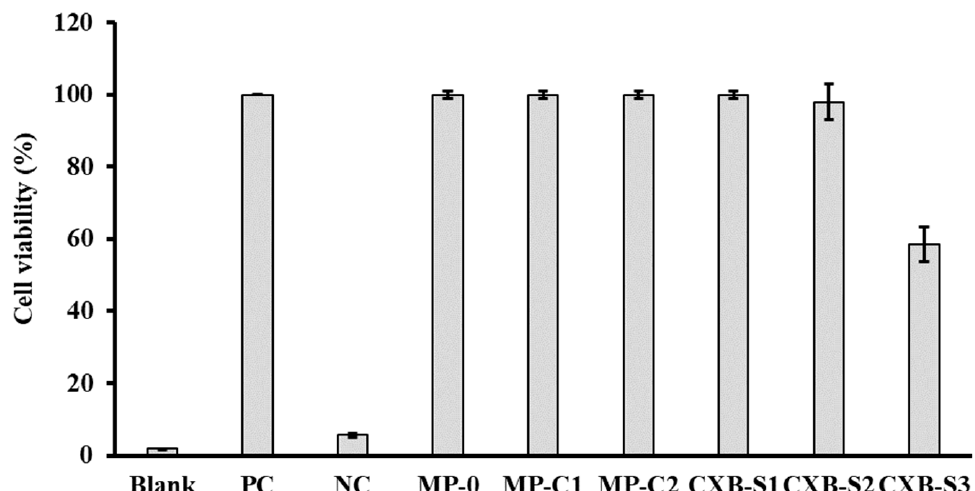
Figure 3. Cell viability results (±SD) obtained after the incubation of macrophages with formulations MP-0, MP-C1, MP-C2, CXB-S1 (12 µg/mL), CXB-S2 (24 µg/mL) and CXB-S3 (48 µg/mL). PC: positive control (live macrophages), NC: negative control (dead macrophages).